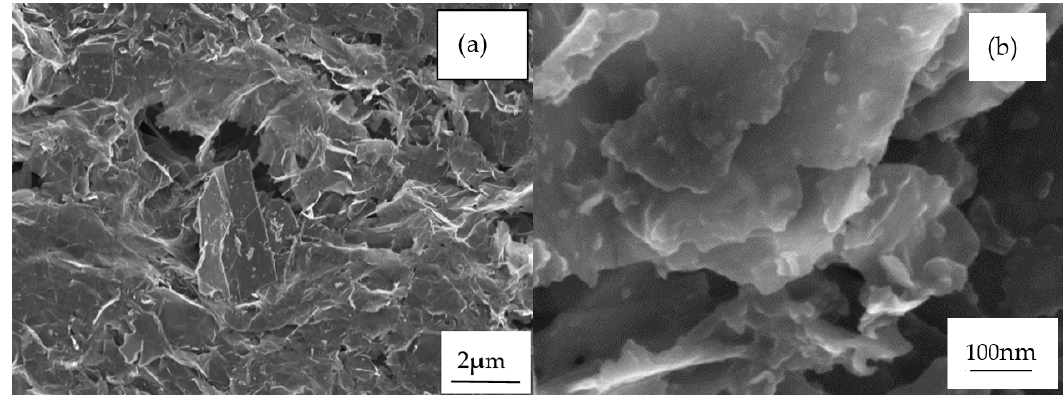
Figure 2. SEM images of ( a ) the expanded graphite and ( b ) fuel-modified graphene.